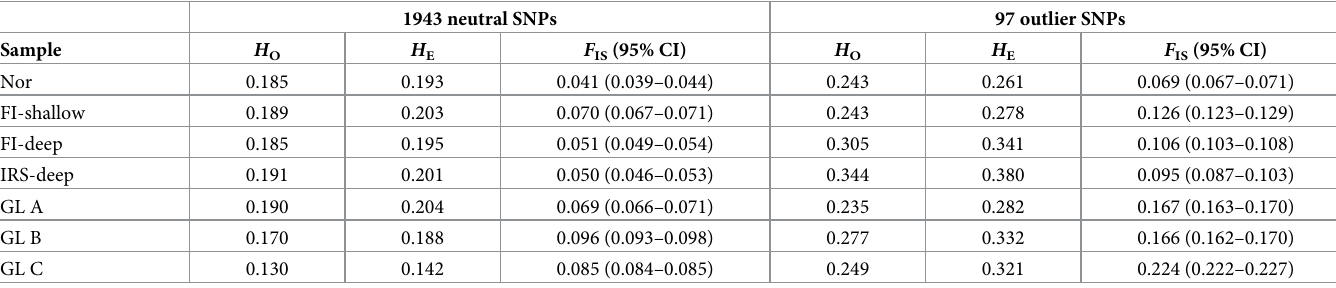
Table 2. Descriptive statistics for S . mentella collections based on the selected 1,943 neutral and 97 outlier SNPs.